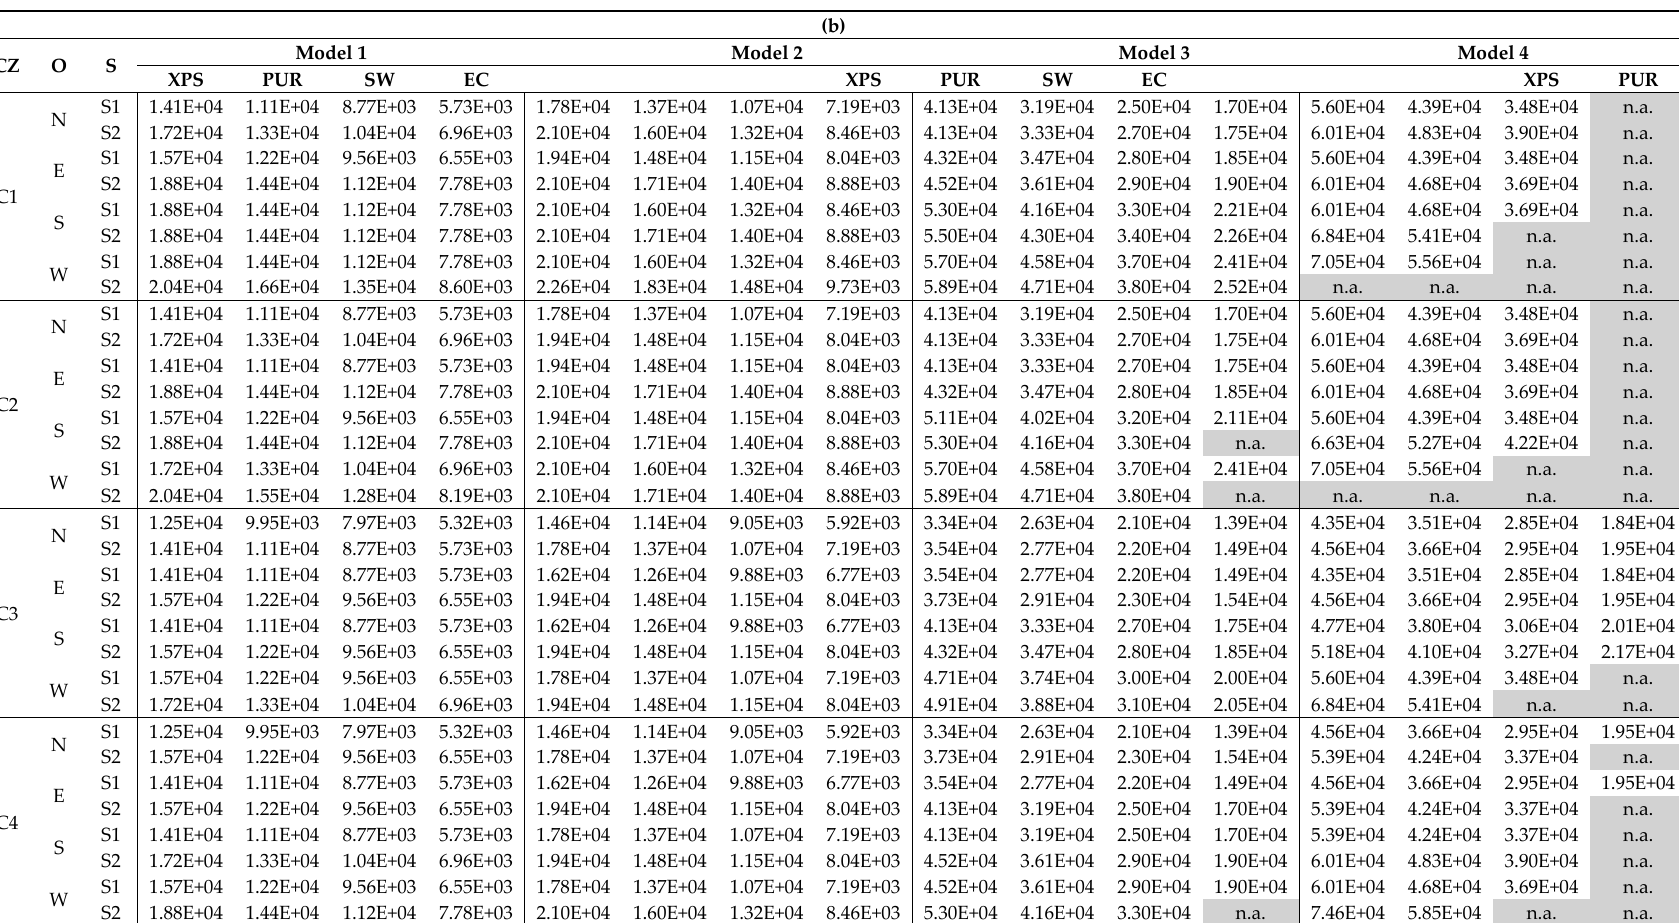
Table A6. Emissions of CO 2 according to climate zone (CZ), orientation (O), constructive solution (S), building model and insulation material model (in Kg CO 2 ), for H3.